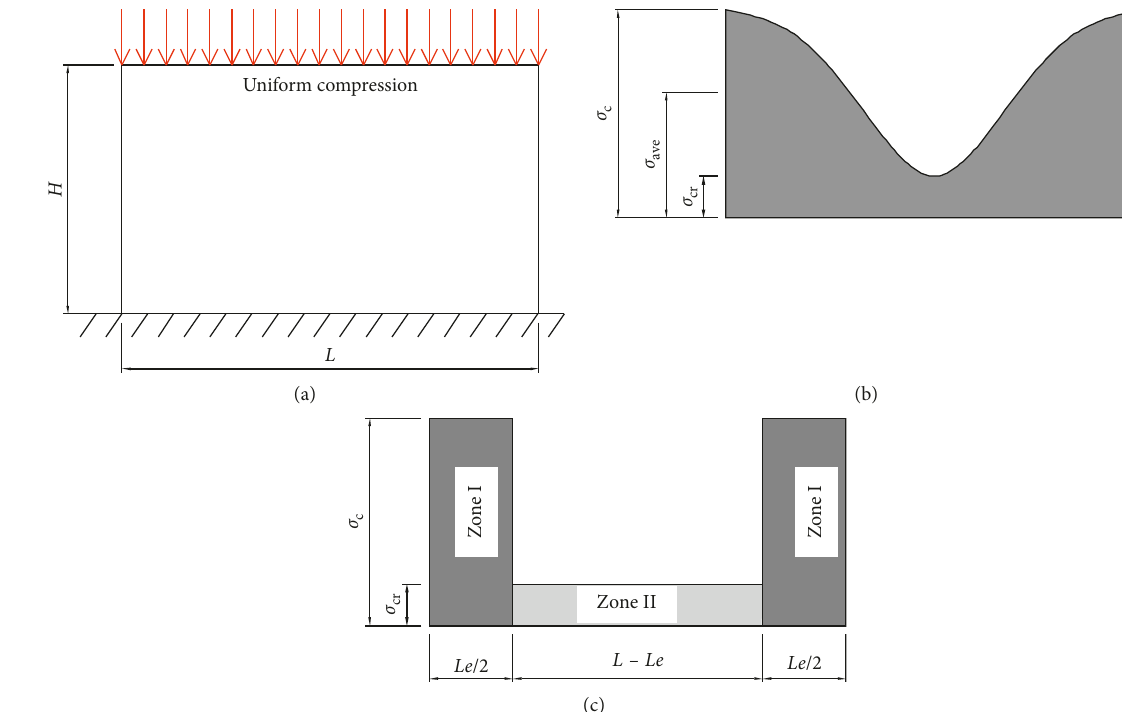
Figure 10: Schematic diagram of the equivalent compression stress after elastic